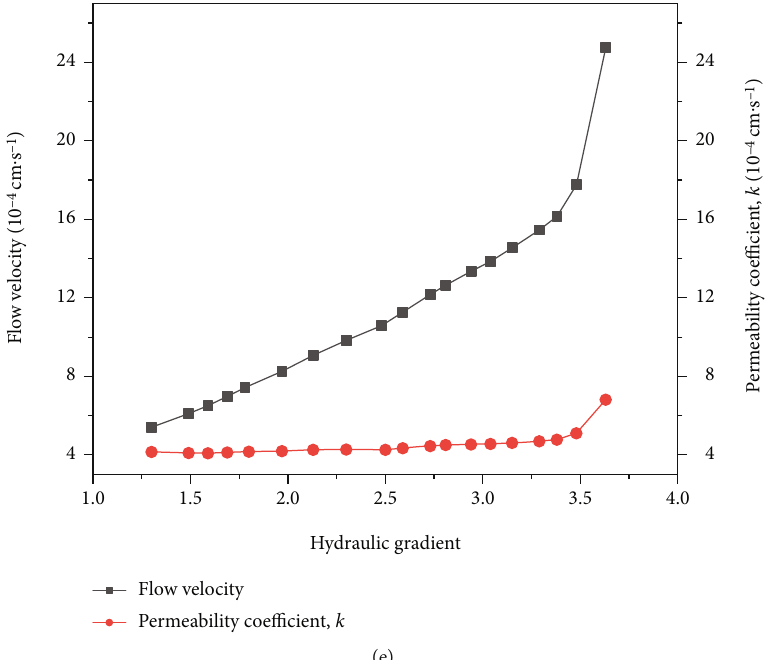
Figure 7: The relationship curve of the hydraulic gradient with seepage velocity and permeability coe ffi cient: (a) the fi rst group; (b) the second group; (c) the third group; (d) the fourth group; (e) the fi fth group.